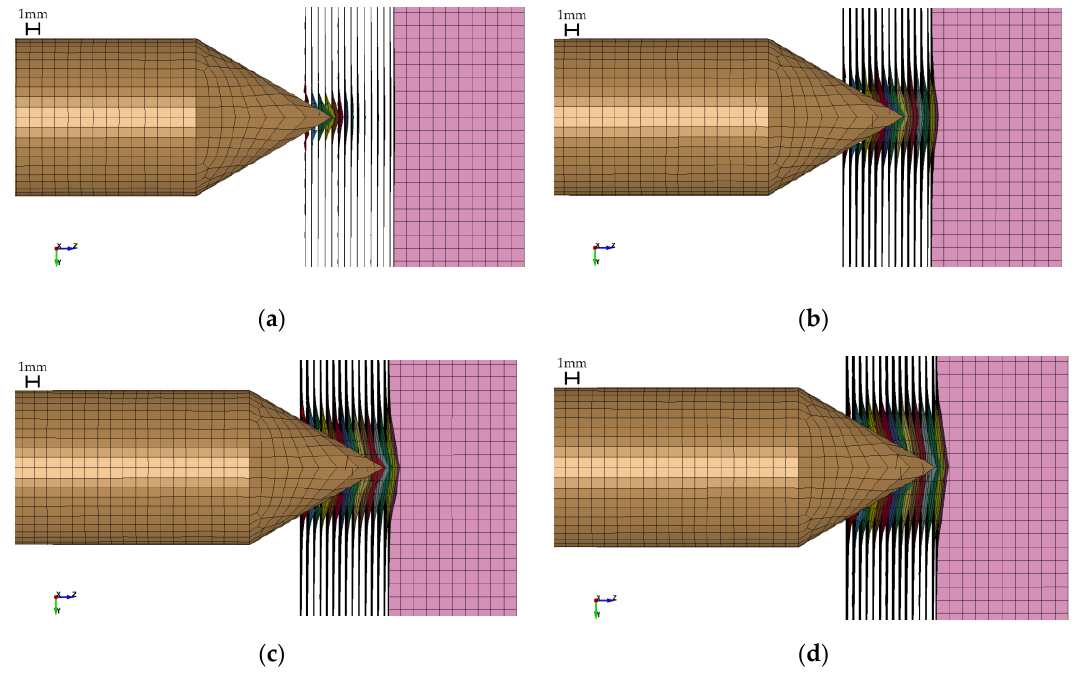
Figure A3. Damage caused by the conical striker at different instances of the simulation: ( a ) time = 0.1 ms, ( b ) time = 0.2 ms, ( c ) time = 0.3 ms, ( d ) time = 0.35 ms.